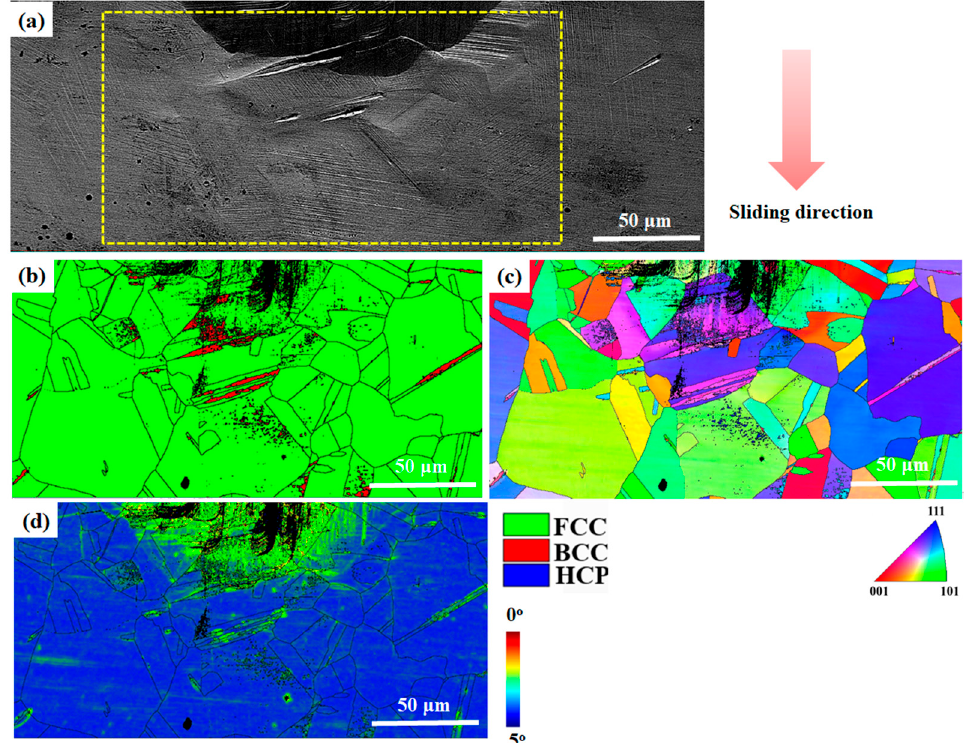
Figure 7. ( a ) SEM image the front part of the wear track of the 304 stainless steel with a grain size of 48 μ m after dry sliding test with an applied load of 80 N. ( b – e ) Electron backscattered diffraction (EBSD) analysis of the transformation of austenite to martensitic in the front of wear track: ( b ) phase map, ( c ) inverse pole figure (IPF) map, and ( d ) kernel average misorientation (KAM) map.